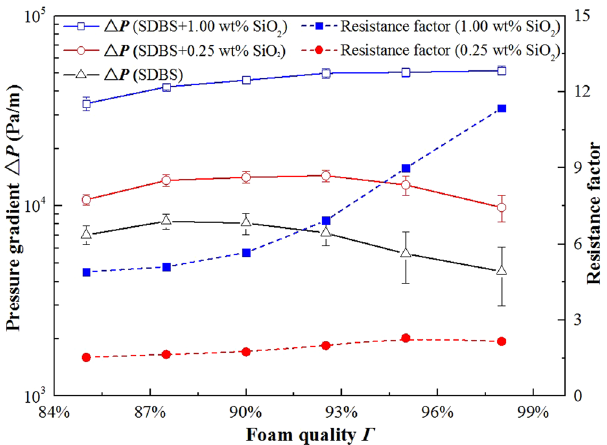
Figure 11. Pressure gradient ∆ P and foam resistance factor as a function foam quality Γ . SDBS concentration was kept at 0.1 wt% and SiO 2 nanoparticle concentration was 0.25 wt% or 1.00 wt%. Flow velocity ν was kept at 5